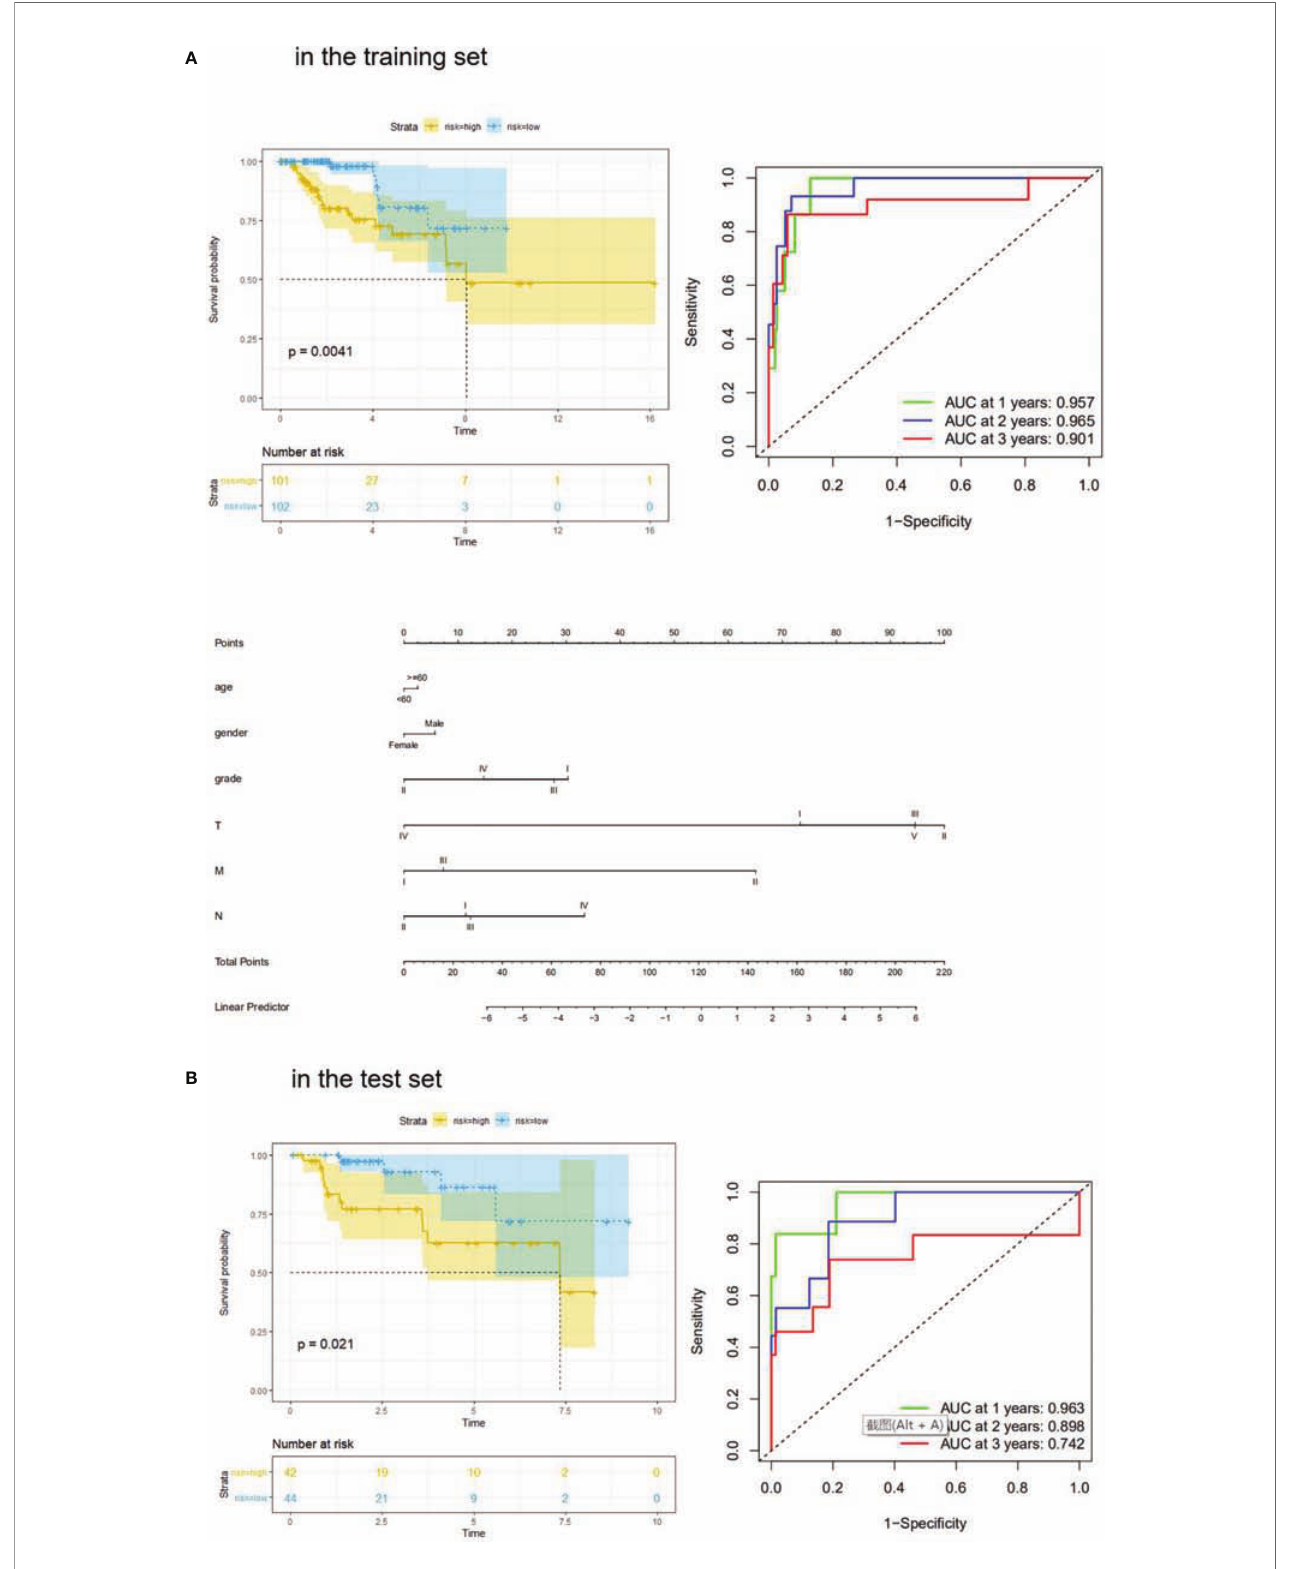
FIGURE 5 | KM analysis and ROC analysis of risk score value in both sets. (A) KM analysis, ROC analysis, and clinical nomogram model of risk score value in the training set; (B) KM analysis, and ROC analysis of risk score value in the test